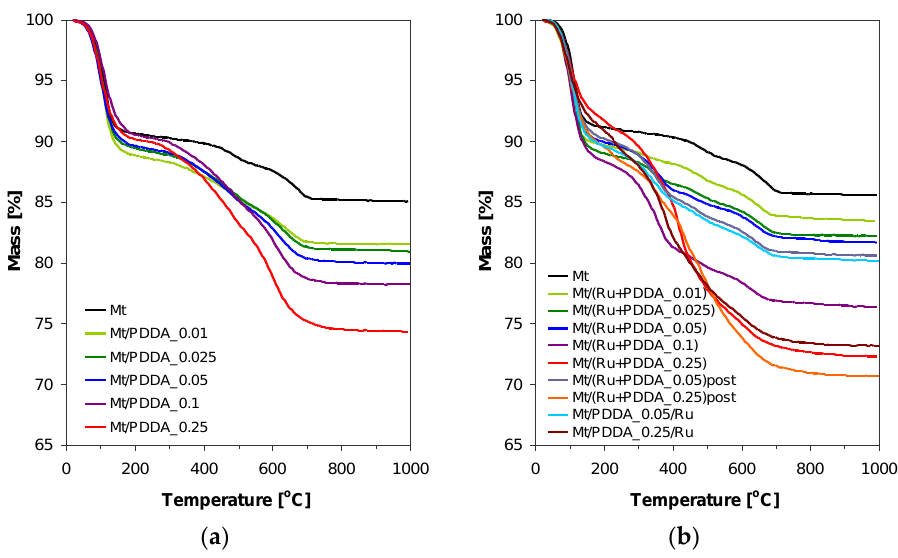
Figure 6. TG profiles of: ( a ) PDDA-intercalated montmorillonites; ( b ) Ru-loaded PDDA-intercalated montmorillonites. TG of parent montmorilllonite is provided for comparison.